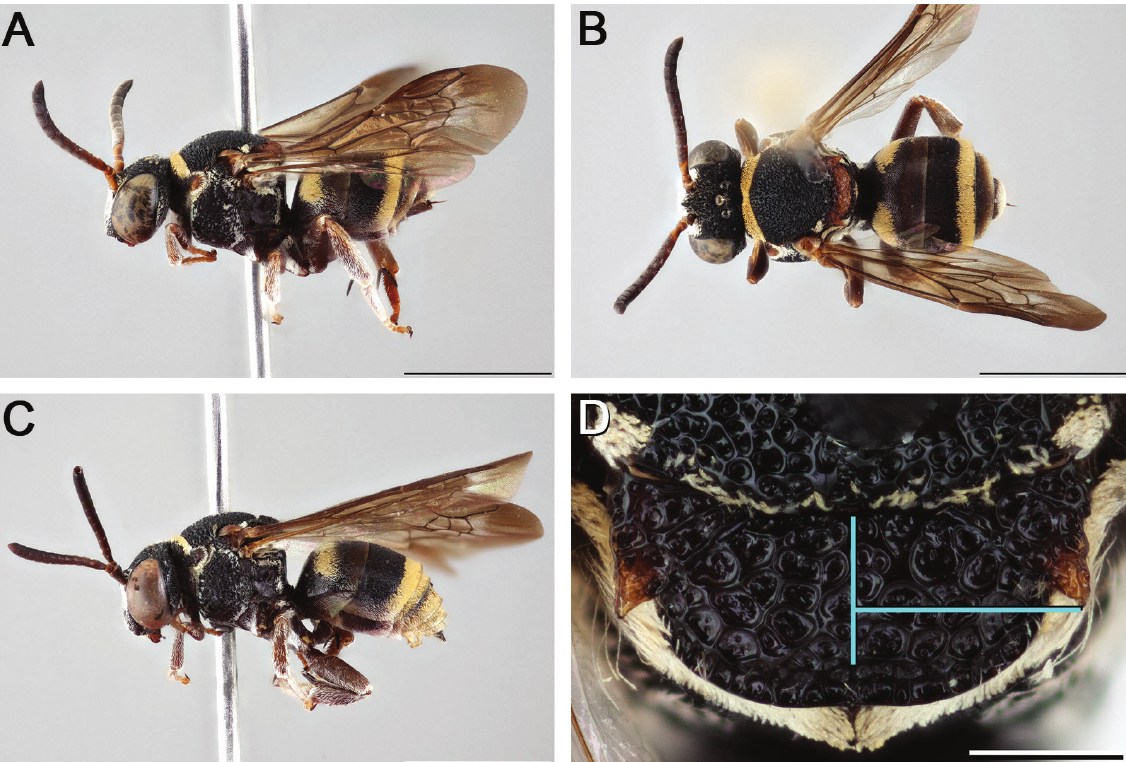
Fig. 17. Epeolus obscuripes Cockerell, 1917 stat. nov. A . Female, habitus, lateral view. B . Female, habitus, dorsal view. C . Male, habitus, lateral view. D . Female axillae and mesoscutellum, dorsal view (blue lines indicate the posterior extent of the axilla relative to the length of the horizontal dorsal portion of the mesoscutellum). Scale bars: A–C = 3 mm; D = 0.5